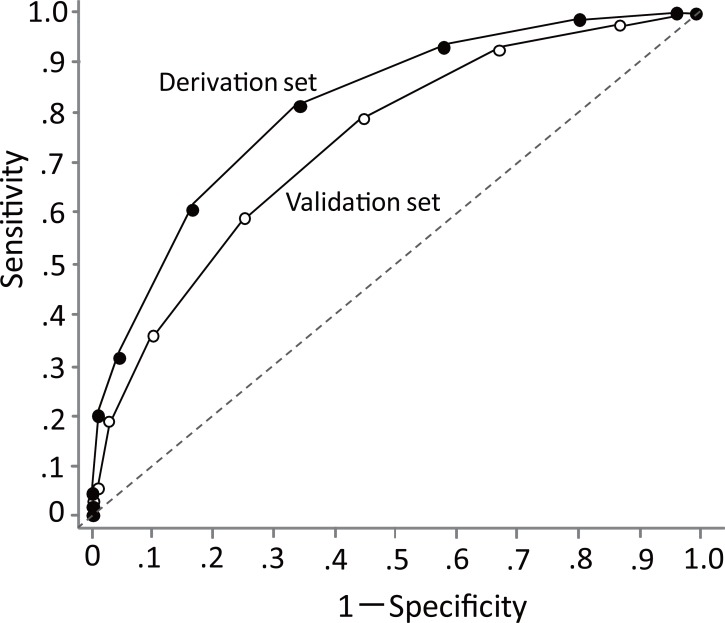
Fig 3 shows the ROC curves for the ID-BactER score.ROC curves of ID-BactER score. The ●s indicate results from the derivation set, and the ○s indicate results from the validation set. The areas under the curves are 0.80 (95% CI, 0.77–0.83) for the derivation set and 0.74 (0.68–0.80) for the validation set.